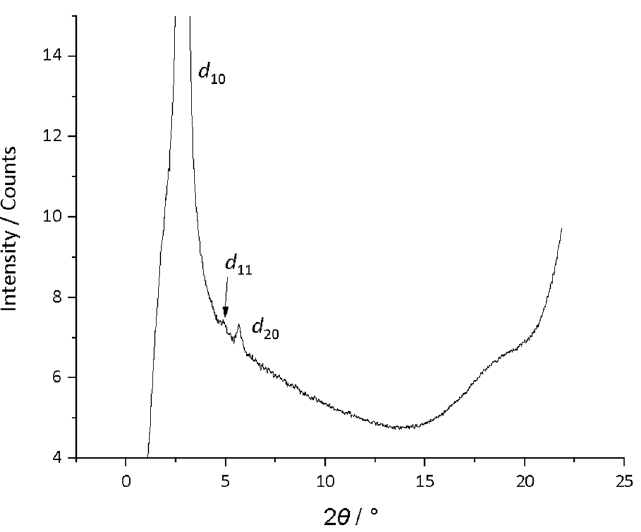
Figure 6. Diffraction pattern of the Col h phase formed by compound 4 -10 at 105 °C on